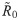
Modified basic reproductive ratio R˜0, unlike the time-averaged R¯0, accurately predicts infection outcome under a periodic drug treatment.(A) Time course of infection levels (concentration of mature infected cells, y(t)) for an unsynchronized strain (T = 2 days and τ = 5 days). The maturation time is fixed and drug levels are modeled as a periodic step function. Unsynchronized strains are more exposed to the drug effects, as they overlap less with the off-windows of the drug treatment. (B) Synchronized strains (τ = 2) are less exposed to the drug effects, as they overlap with the off-windows of the drug treatment. The off-windows in the drug treatment are represented by blue shading. In this example, we use drug period T = 2 days and drug efficacy f = 0.75. (C) The time-averaged basic reproductive ratio minus one (R¯0-1) is plotted versus the maturation time (τ) for a fixed drug efficacy and the simple on-off model of drug levels (black line). R¯0 is independent of maturation time when immature cells do not die (dw = 0 here) and weakly dependent for dw ≪ m. R¯0<1 versus R¯0>1 is unable to explain the observed persistence versus extinction of viral strains (e.g. Fig 2). We derived a new quantity, R˜0 (blue line), which works in the presence of synchronization to describe the observed behavior. R˜0 was obtained via numerical solution of Equation (S.99) for r˜0 and substitution of r˜0 into Equation (S.100). The equilibrium infection level for a single strain (red line) is scaled to match R˜0-1 at τ = 1.8. The drug efficacy is set to f = 0.9, and the death rate of immature infected cells is zero (dw = 0). (D) Same as (C), except the drug efficacy is set to f = 0.5, and the death rate of immature infected cells is non-zero (dw = 0.1). The equilibrium infection level is scaled to match R˜0-1 at τ = 0. Connecting lines between points are drawn as a guide for the eye.